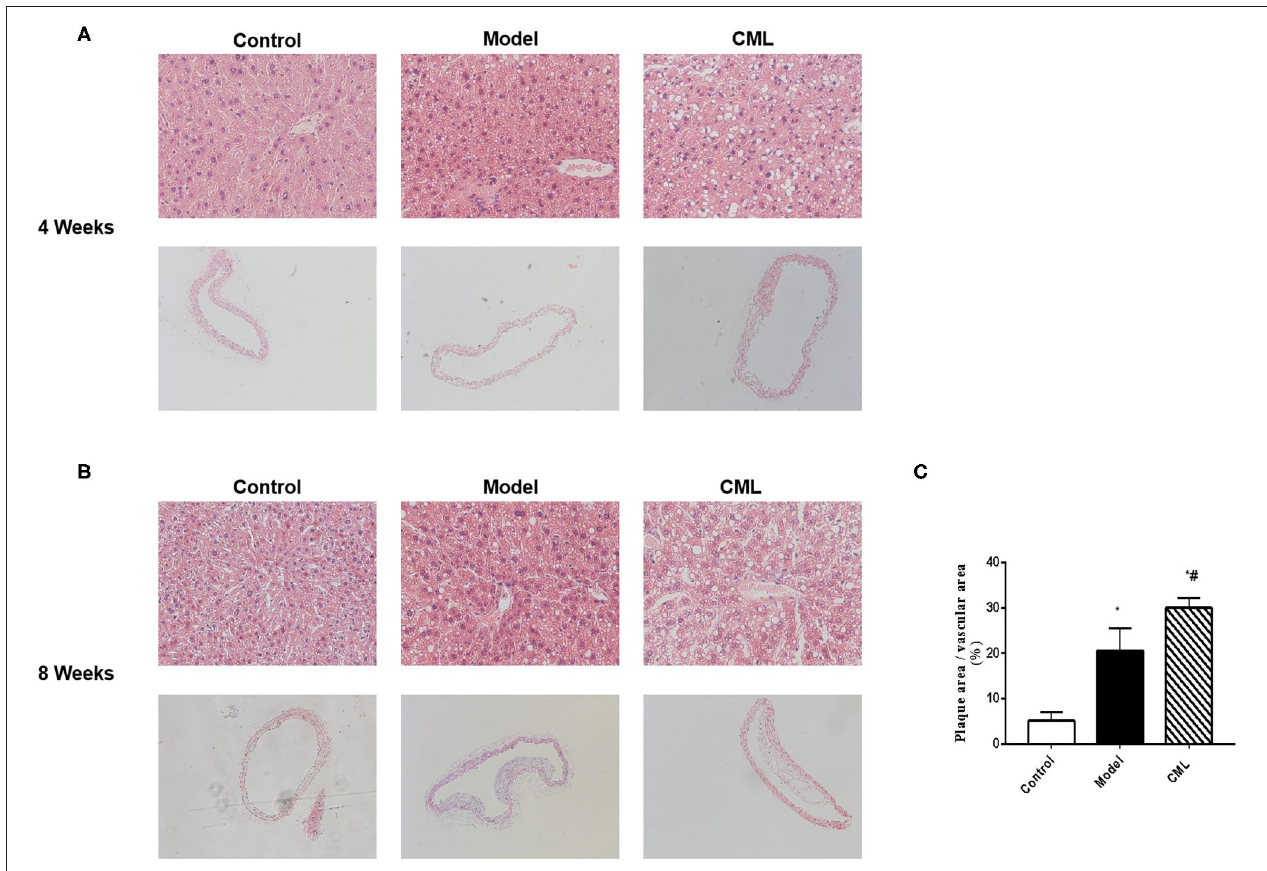
FIGURE 2 | CML promotes high fat-induced liver steatosis and intravascular plaque formation in ApoE − / − mice (A,B) . At the time of 4, 8 weeks, ApoE − / − mice liver ( × 200) and aorta H&E staining ( × 100) (C) . Image J analyzes plaque area.* P < 0.05, compared to control group; # P < 0.05, compared to model group.